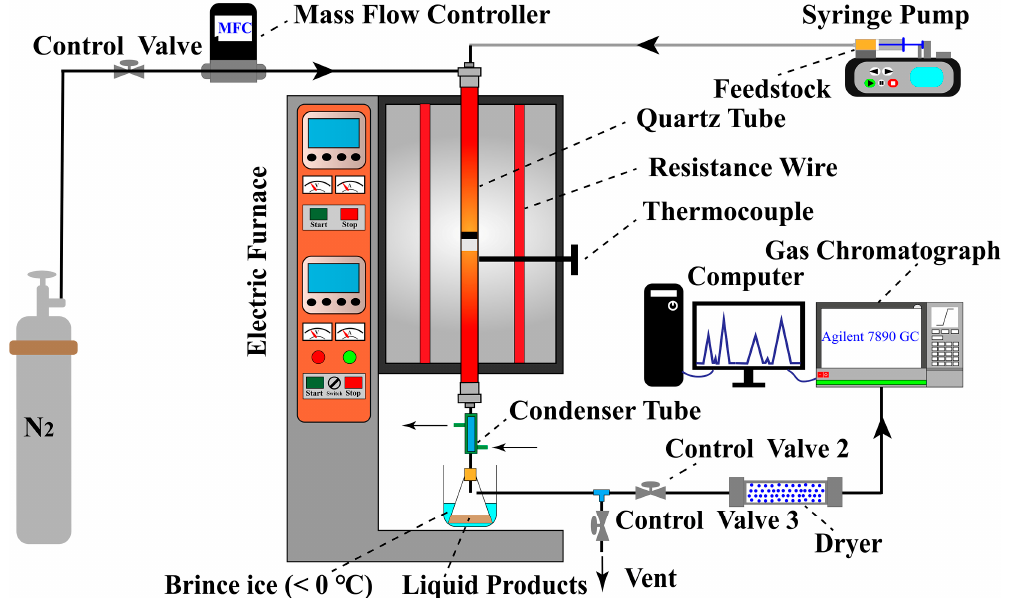
Figure 2. Schematic layout of WCO-Biodiesel pyrolysis experimental setup.